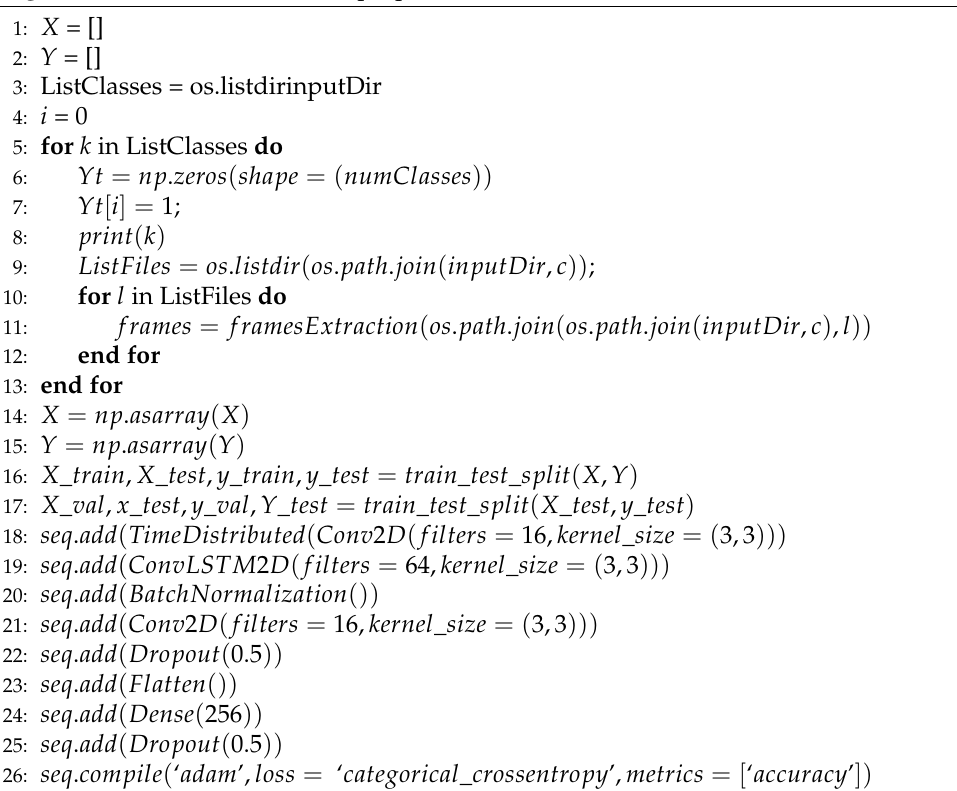
Algorithm 1 Pseudo-code of the proposed ConvLSTM